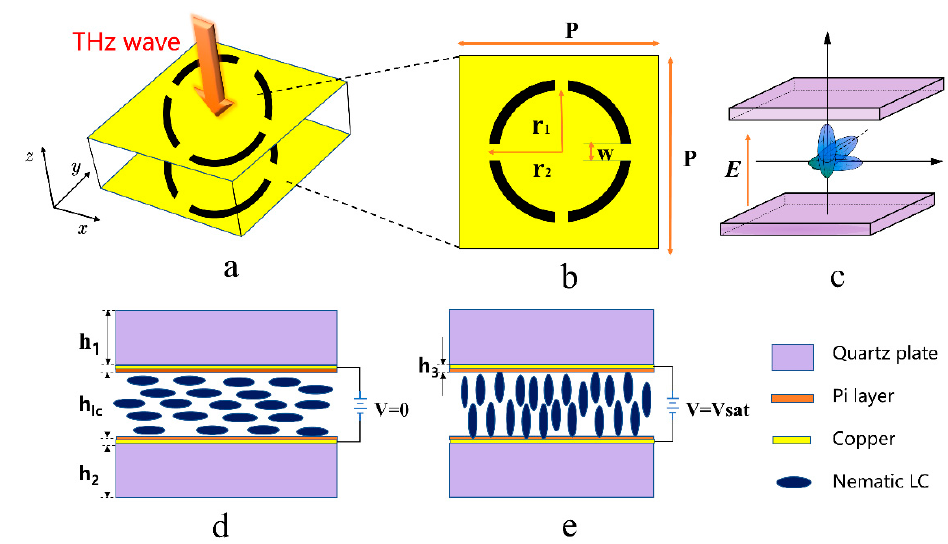
Figure 2. ( a ) The unit cell structure. ( b ) Layout of the unit cell structure of the copper pattern. ( c ) Orientation of the LC molecules with different electric fields. ( d , e ) Side view orientation of the LC molecules for biased and unbiased states.